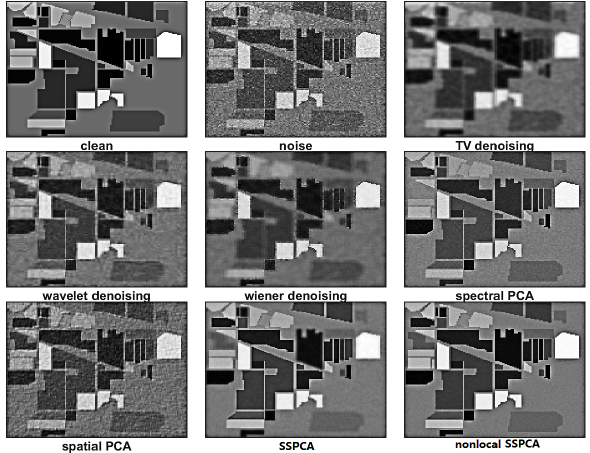
Figure 3. Denoising results achieved by different methods, on band 1 of simulated data. Denoised image by the proposed nonlocal SSPCA method is the most similar one to the true image. The other methods tend to either preserve undesirable artifacts or oversmooth and weak signal.